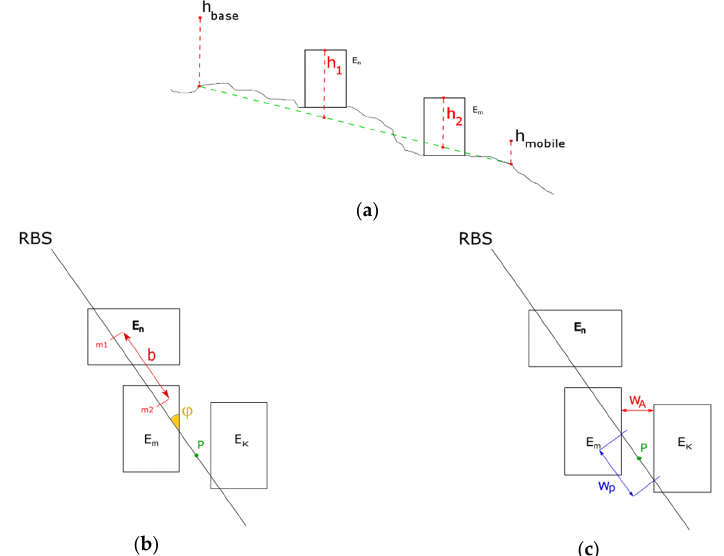
Figure 2. New definition of parameters for the COST231–Walfisch–Ikegami model [24]: ( a ) Schematic drawing of the re-defined parameter hroof to account for the hilliness of a given urban scenario; ( b ) Representation of the two possible definitions of parameter w . In this work, the definition w = w p is used [24]. ( c ) Definition and representation of the parameters b and φ . The rectangular boxes, named respectively, En, Em, and Ek, are the buildings crossed by the electromagnetic field during its propagation path from the RBS (see label in black) to the point P (see label in green). In addition, h base , h mobile , and h 1,2 represent the RBS height, the point P height, and the building height, respectively. Finally, the w , b , and φ parameters are the width of the roads in the built-up area, the building separation, and the road orientation with respect to the radio path, respectively